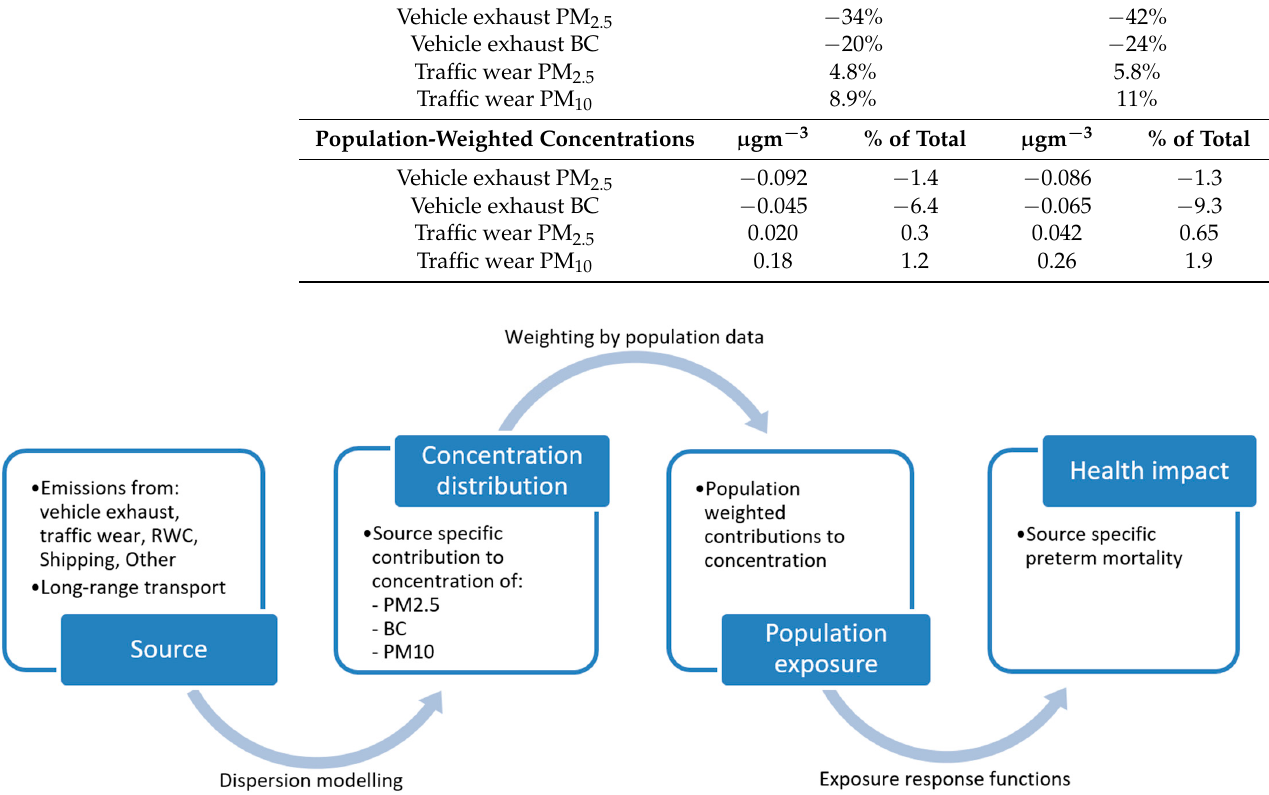
Table 5. Estimated changes relative to baseline due to electrification of 50% of light vehicles. Emissions